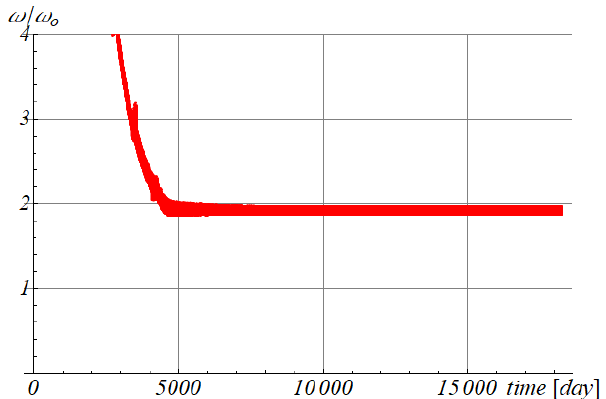
Figure 19. Angular velocity to orbital angular velocity ratio ω / ω 0 in case of resonance